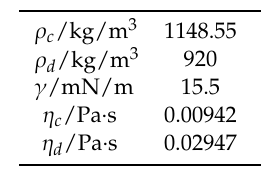
Table 1. Overview of all material